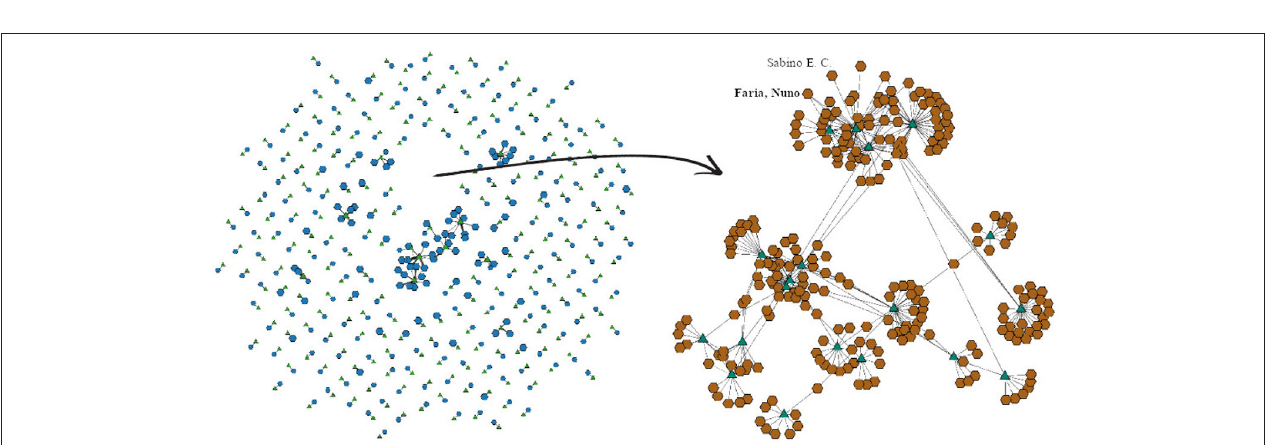
FIGURE 10 | (A) Original scientific collaboration network formed by | V 1 | = 3,531 authors, | V 2 | = 451 papers and 5,058 links. (B) the network coarsened at level 3, with | V 1 | = 563 author nodes, | V 2 | = 264 paper nodes, and 351 super-links. Purple hexagons depict author nodes or super-nodes, green triangles depict paper nodes or super-nodes.